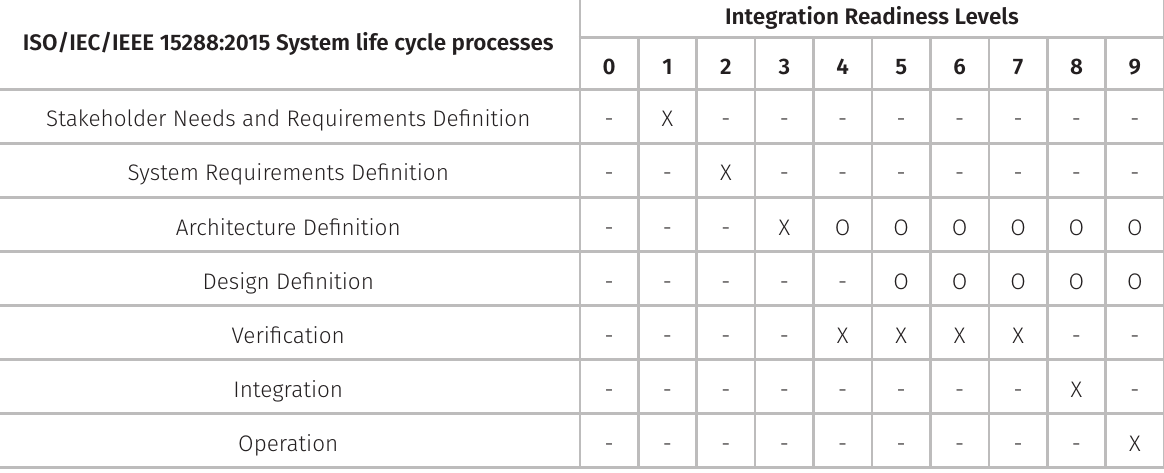
ISO/IEC/IEEE 15288:2015 System life cycle